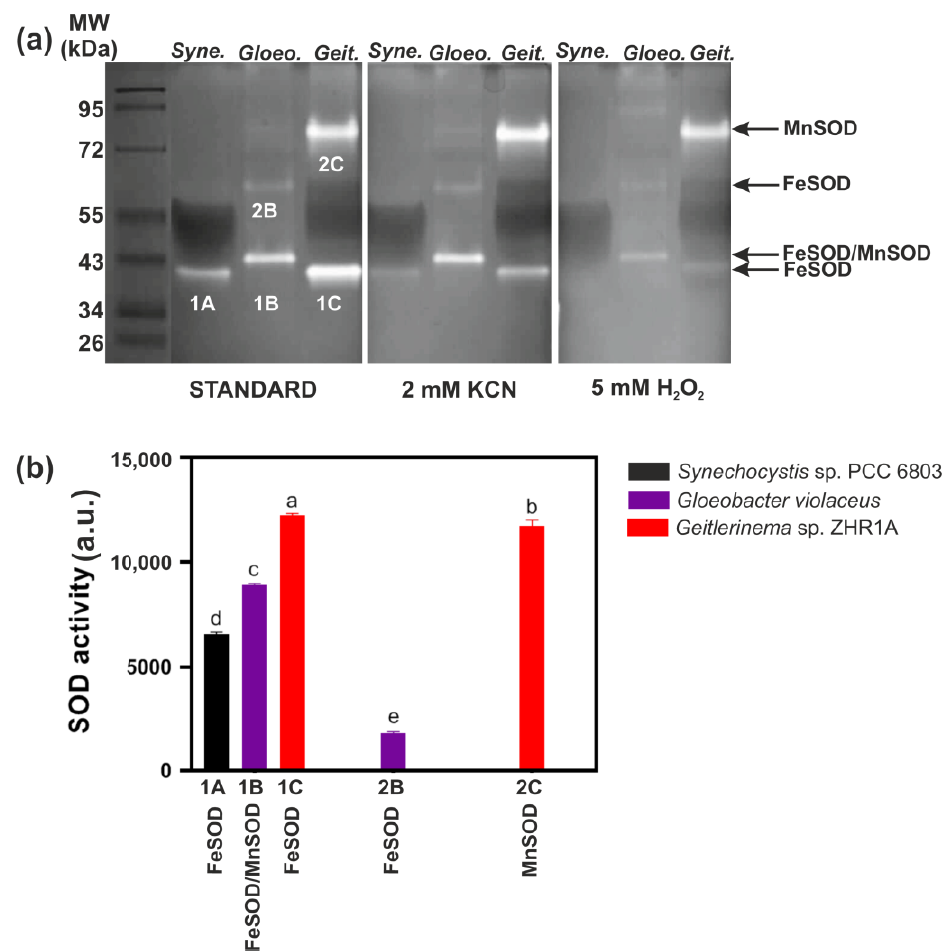
Figure 2. Activity of SOD forms in three species of cyanobacteria: Synechocystis sp. PCC 6803 ( Syne. ), Gloeobacter violaceus ( Gloeo. ), and Geitlerinema sp. ZHR1A ( Geit. ). ( a ) Identification of the different SOD forms in the assay with inhibitors: KCN and H 2 O 2 ; “standard” denotes a standard staining buffer without inhibitors (see also “Materials and Methods”). 30 µg of protein was loaded on each lane. The in-gel activity bands of SOD from a standard staining buffer: 1A, 1B, 1C, 2B and 2C cut for spectroscopic analysis are shown. The lane with a protein-mass ladder is shown on the left. ( b ) Activity of the SOD forms without inhibitors expressed in arbitrary units (a.u.). Data represent means ± SD ( n = 3). Statistical significance between means at least at p < 0.01 is indicated by different letters above the bars and was calculated by Tukey’s HSD test.